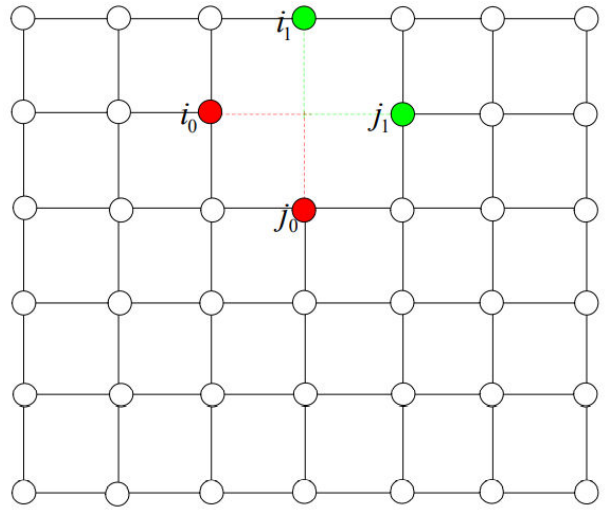
Figure 5. Possible topology of case